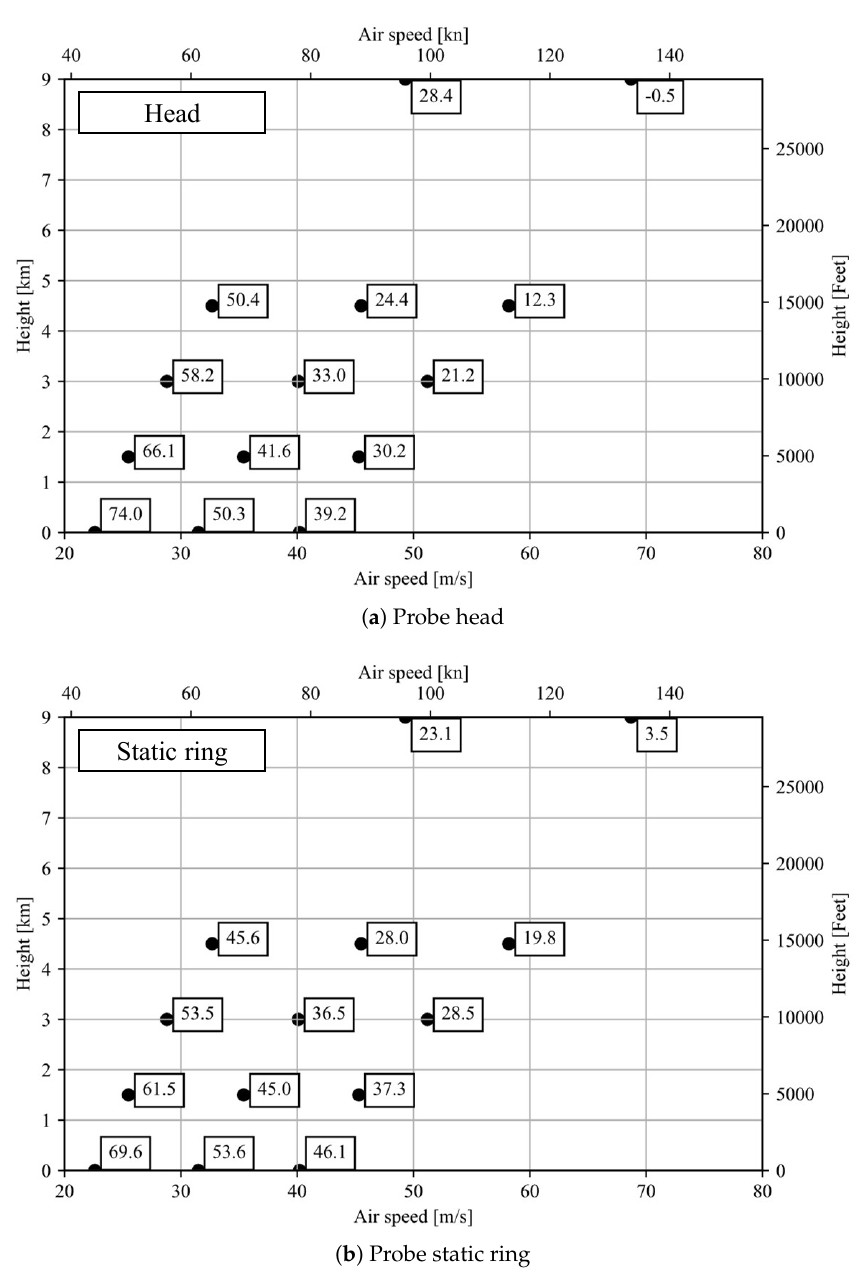
Figure 15. Anti-icing evaluation graph containing test data from configurations 4, 5 and 6 translated to the considered Standard Atmosphere cases in ◦